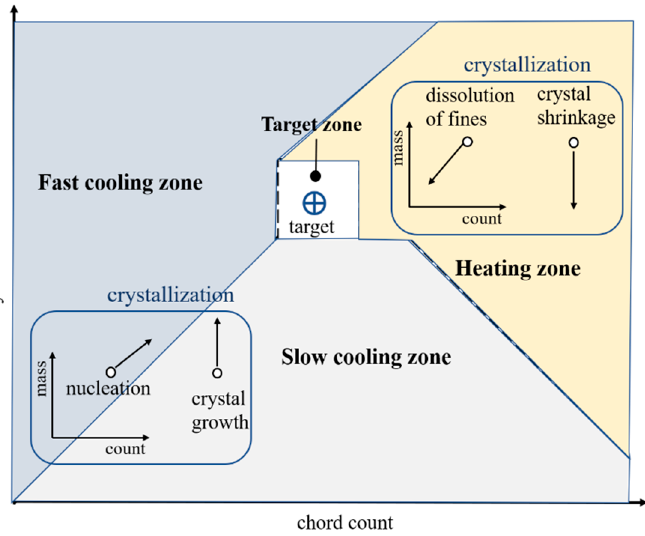
Figure 12. Crystallization and dissolution dynamics illustrated as the movement in mass-count (MC) space and rule-based feedback control policy.